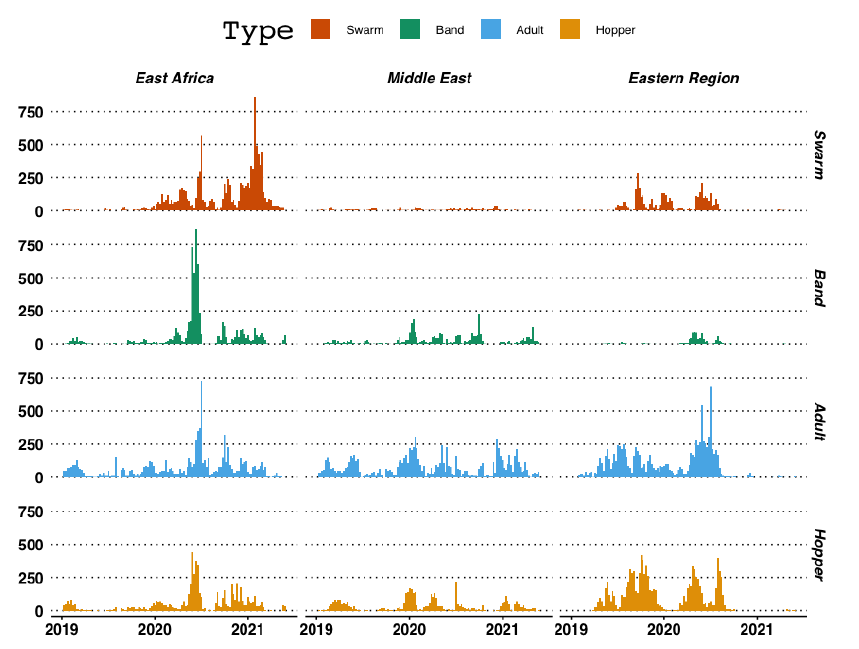
Figure 1. The weekly numbers of desert locust reports. Surveys are categorised as swarms, bands, adults or hoppers. Data from [24] (LocustHub).